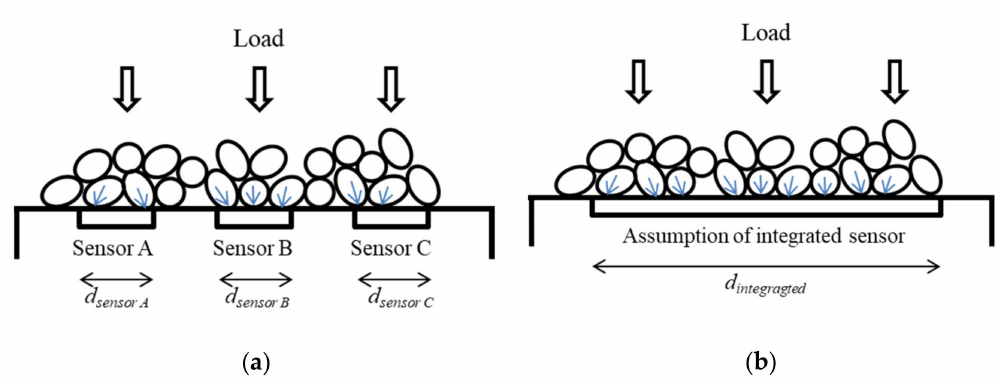
Figure 12. Example of earth pressure sensor with soil particle arrangement: ( a ) before and ( b ) after calibration.